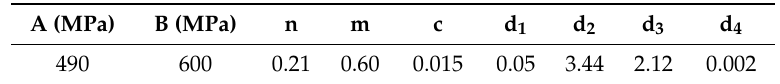
Table 1. Parameters for the Johnson–Cook plasticity model and Johnson–Cook damage model for 316L grade stainless steel